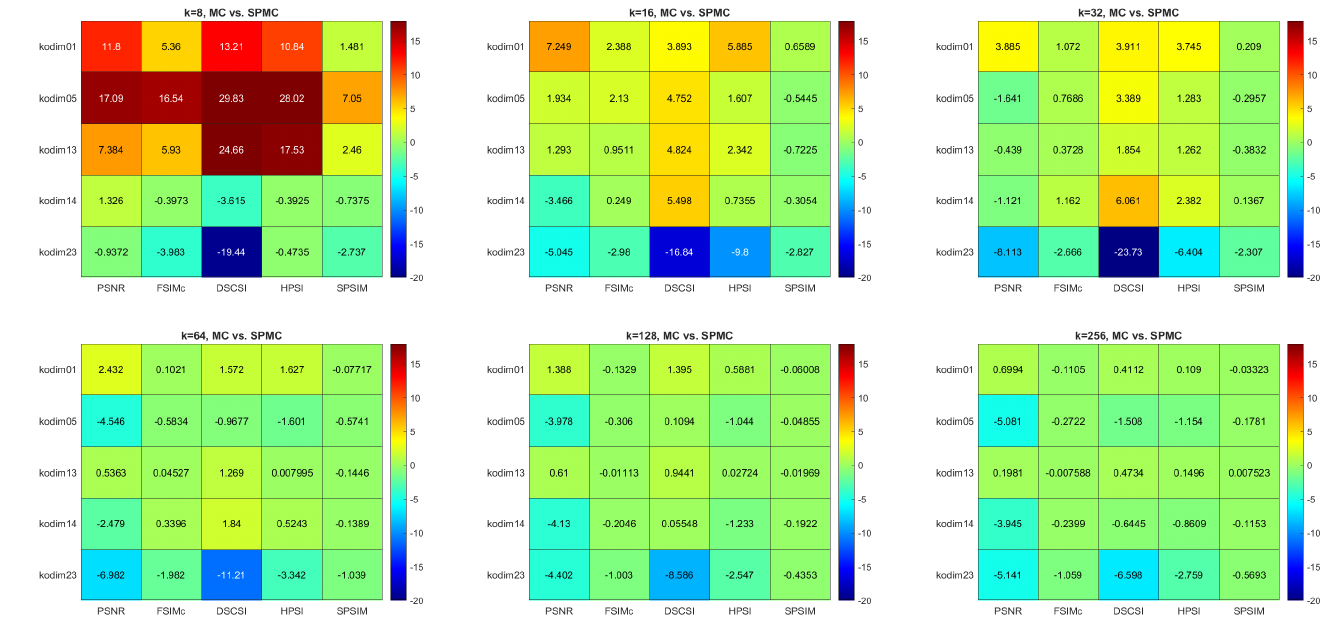
Figure 4. Multi − index quality assessment of quantized images: MC versus SPMC.